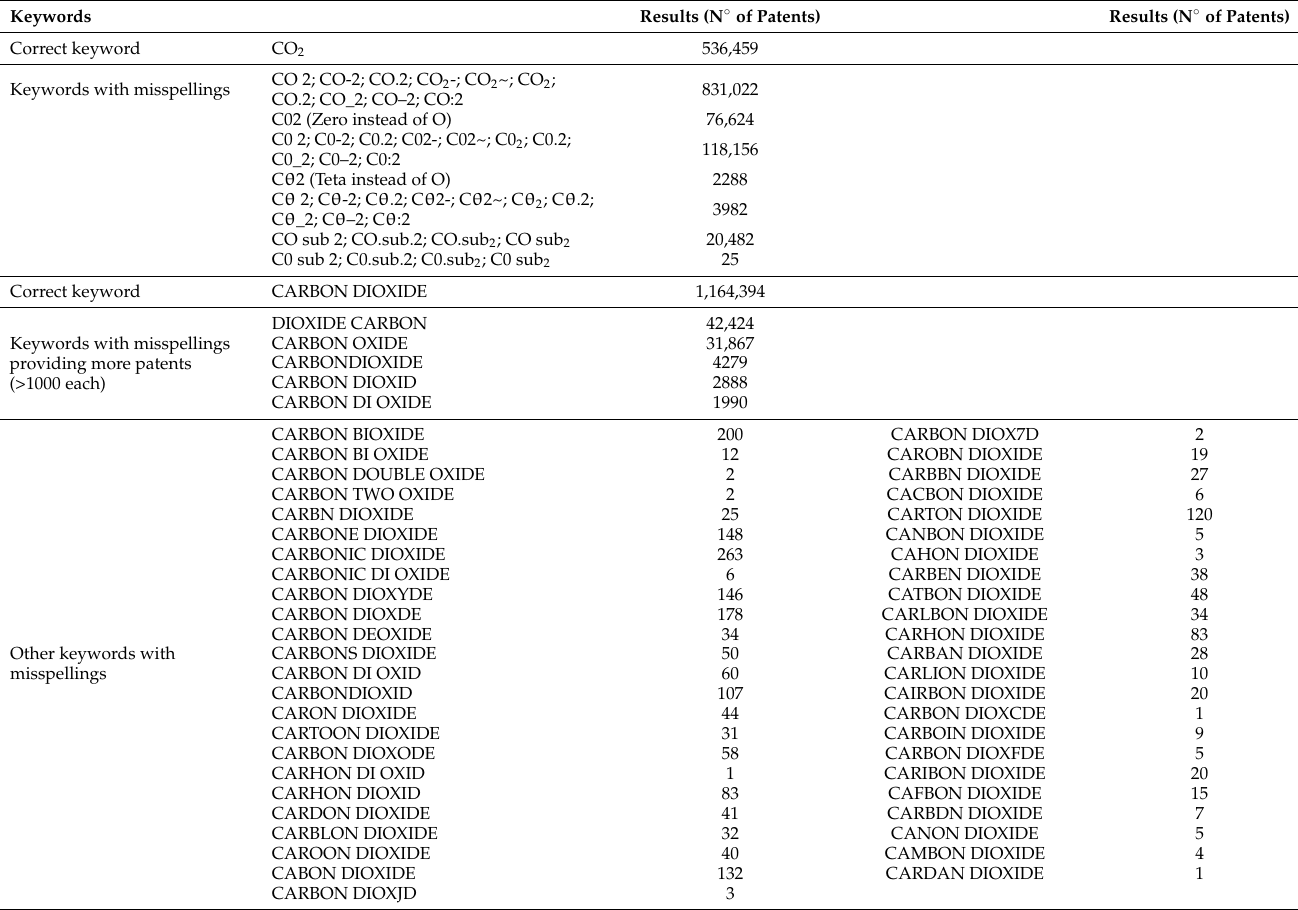
Table 9. Keywords (correct and with misspellings) used to search patents about CO 2 and CARBON